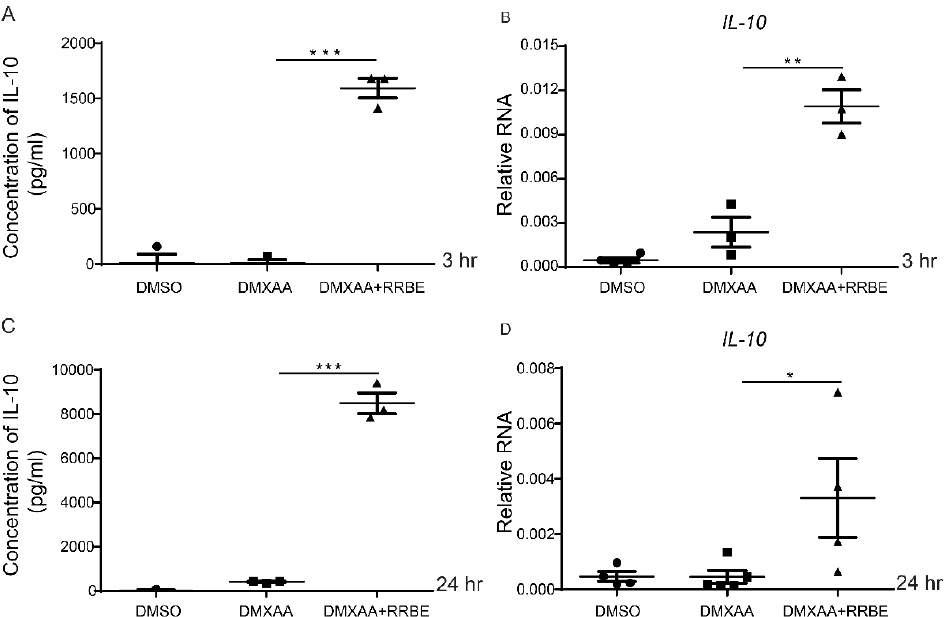
Figure 6. RRBE increases the production of anti-inflammation IL-10. Cells and supernatants were collected, and we analyzed the IL-10 secretion and mRNA expression by ELISA and RT-PRC after DMXAA activation with and without RRBE for ( A , B ) 3 h and ( C , D ) 24 h (N = 3–4). Data shown as mean ± SEM (* p < 0.05, ** p < 0.01 and *** p < 0.001).